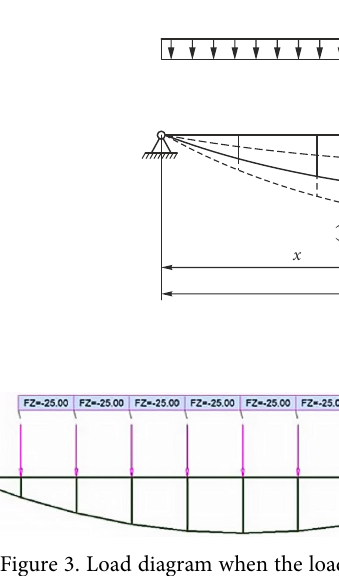
Figure 3. Load diagram when the load is transmitted through the